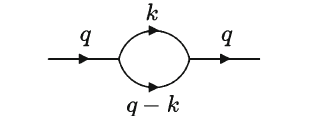
Fig. 5 A two point one loop